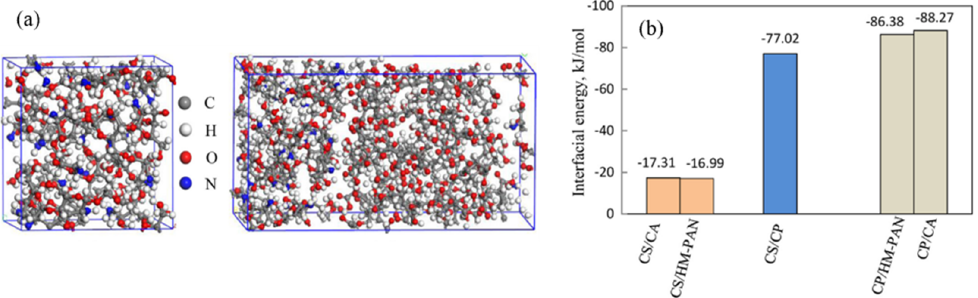
Figure 16. ( a ) The molecular models of the CS active layer and the CS/CP interfacial membrane; ( b )the interfacial energy of the CS/CP composite membrane [77].